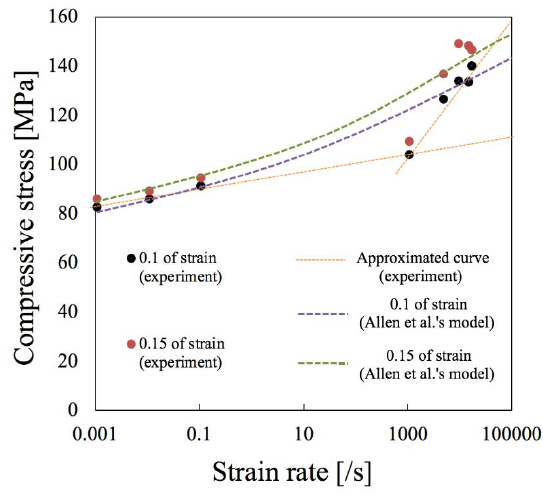
Figure 8. Stress-strain rate relationship obtained by quasi-static to impact tests using the established miniature testing apparatus.